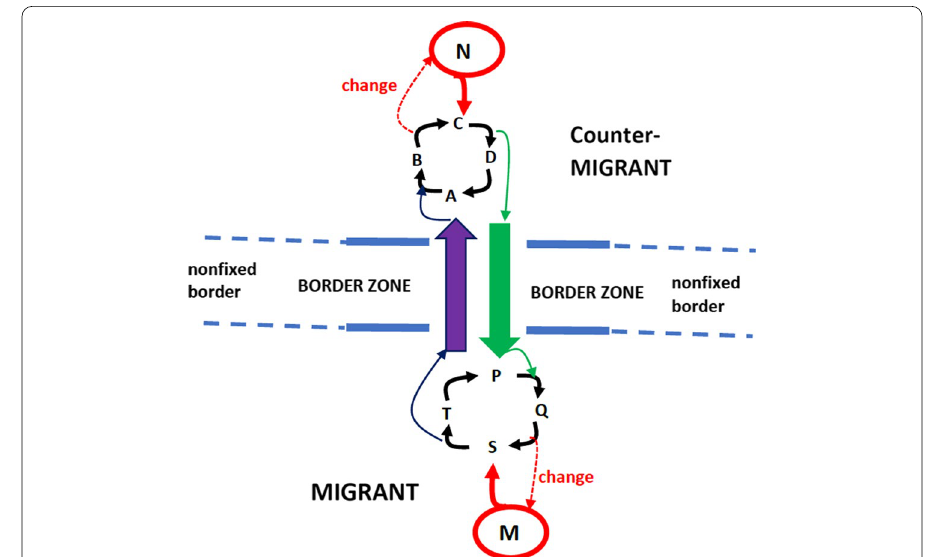
Fig. 4 The process of negotiation of the Migrant<> Counter relations on the border